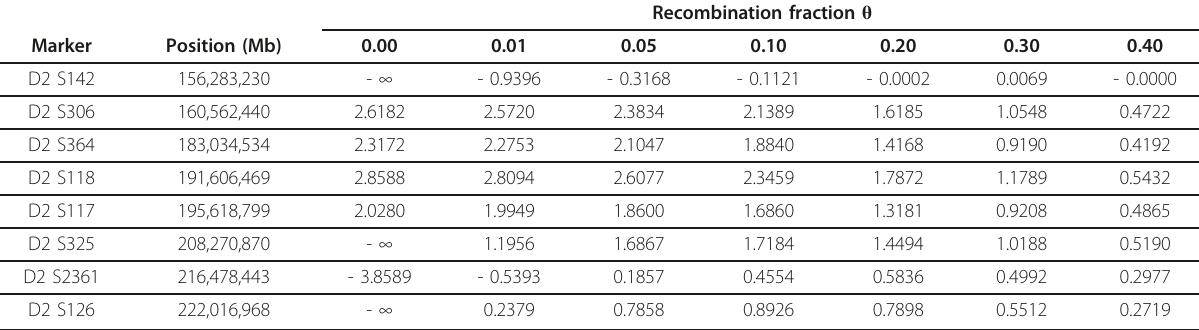
Table 2 Two-point LOD score for microsatellite markers of family RP470 calculated at different recombination fractions